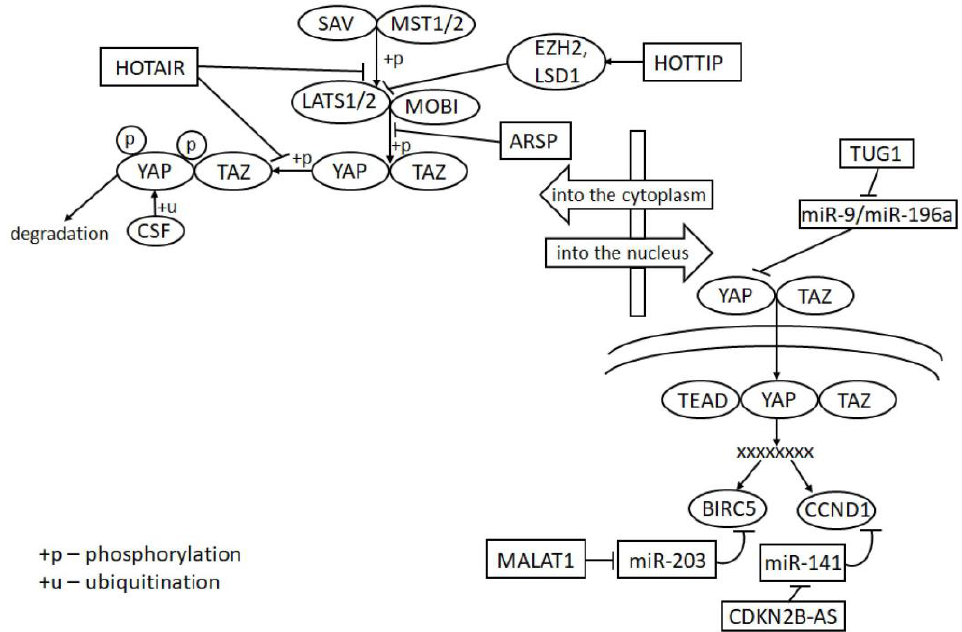
Figure 3. Effects of six lncRNAs (HOTAIR, HOTTIP, ARSP, TUG1, MALAT1, and CDKN2B-AS1) on different steps in the Hippo signaling pathway. lncRNAs and miRNAs are within the rectangles; proteins are within the ovals; the crosses indicate the interaction of transcription factors and their complexes with the regulatory regions of genes.